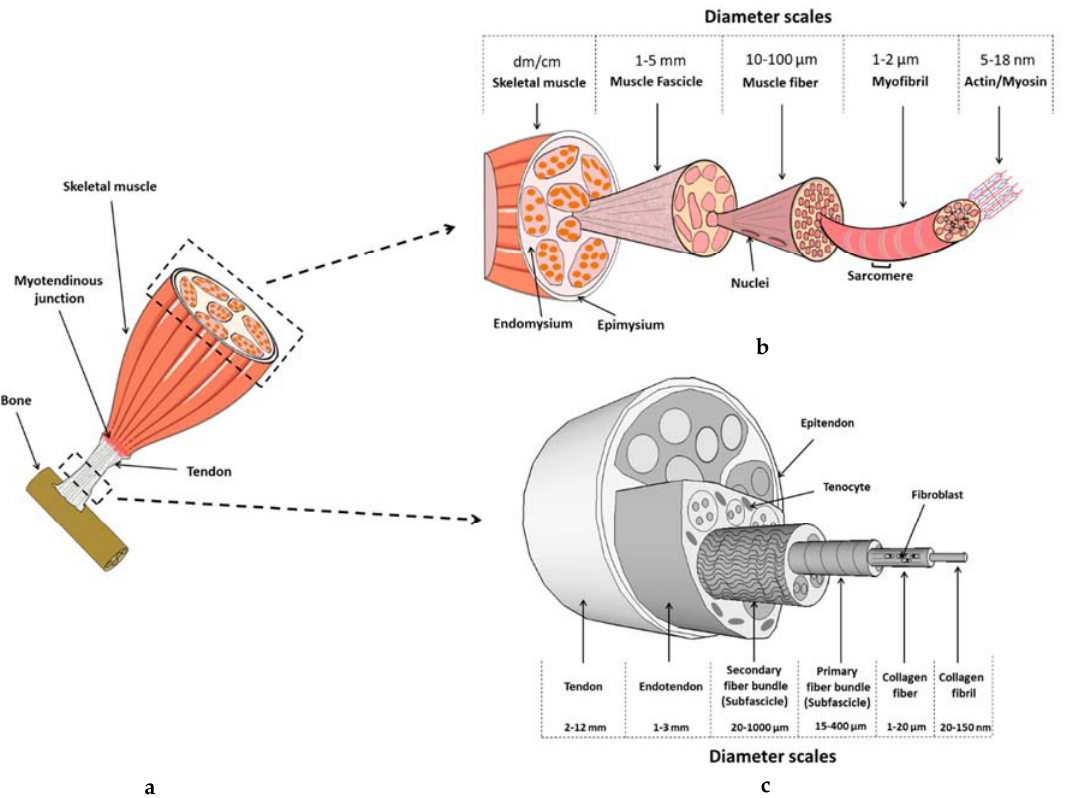
Figure 2. Overview of the bone-tendon-muscle continuum in the human musculo-skeletal system ( a ). Multi-scale description of a skeletal muscle ( b ) and a tendon ( c ).